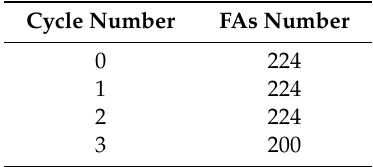
Figure 2. Advanced boiling water reactor (ABWR) full-core configuration of one quarter of the core. Table 2. Fuel assemblies (FAs) number at each